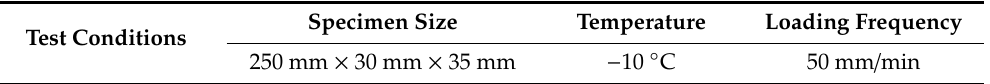
Table 5. Test conditions of low-temperature creep bending test.